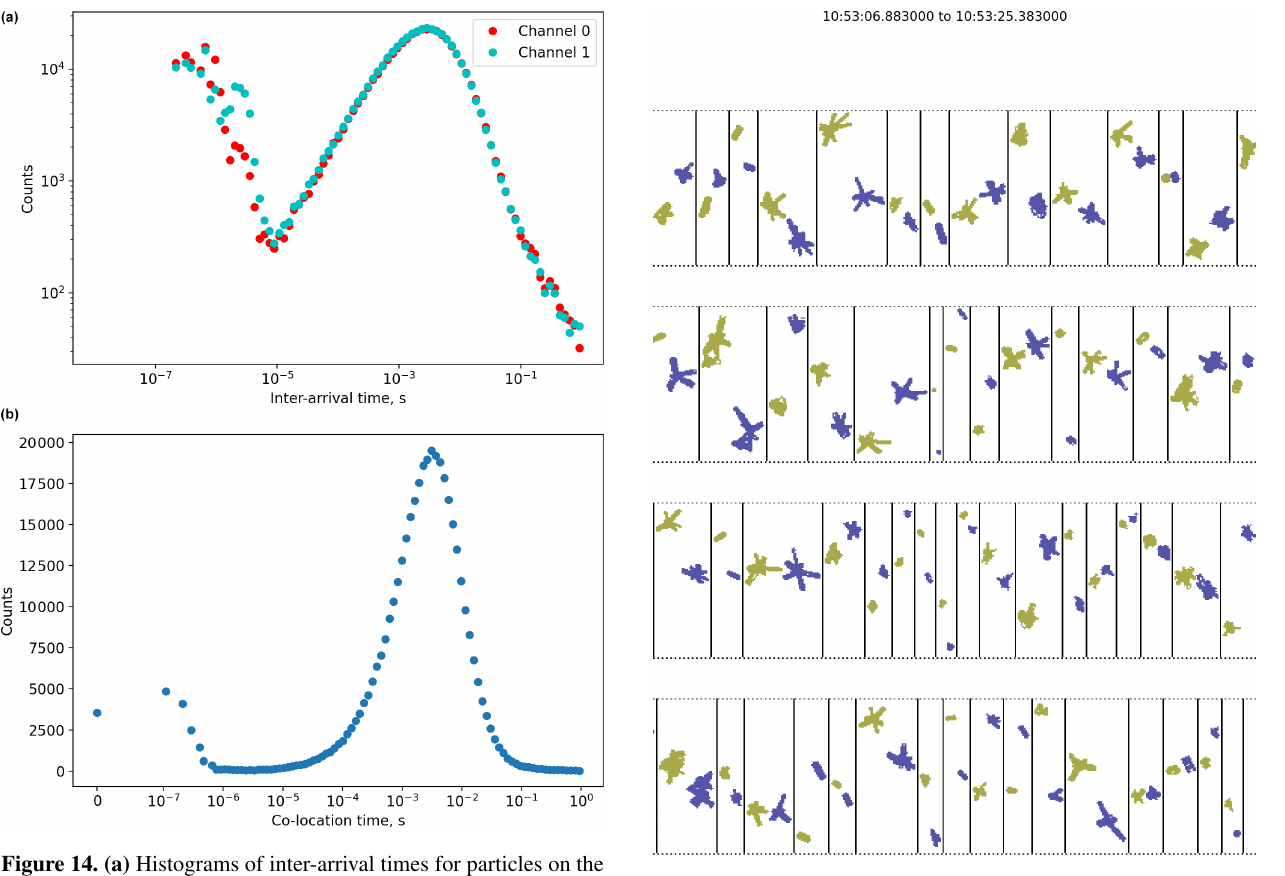
Figure 15. Example ice crystals observed by both channels of the 2D-S. Images from channel 0 are shown in yellow and images from channel 1 are shown in